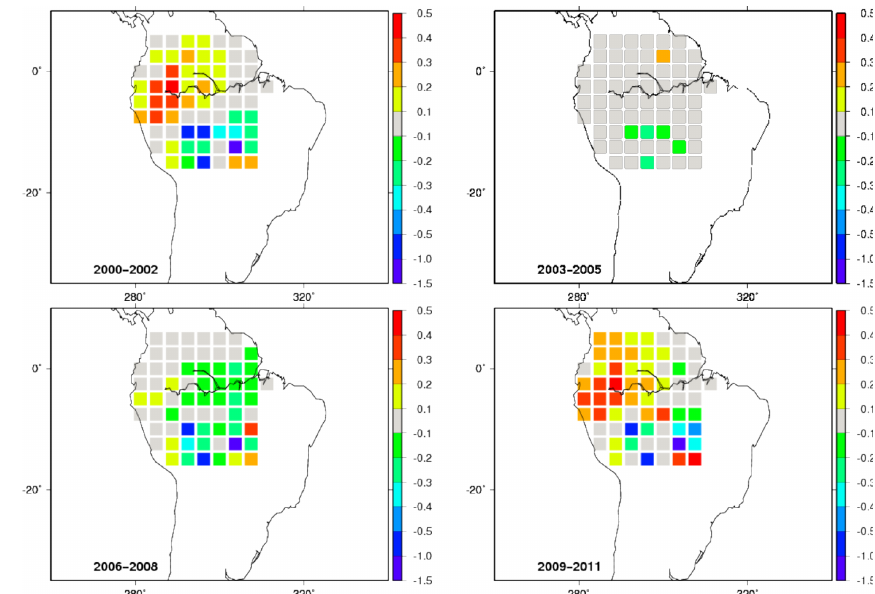
Figure 8. Signal (Tg) for the four 3-year time windows at the pixel